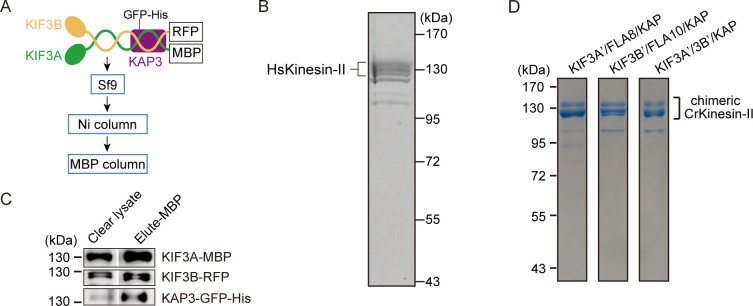
Purification of recombinant HsKinesin-II and chimeric CrKinesin-II with motor domains of HsKinesin-II.(A–C) Expression and purification of recombinant HsKinesin-II. Strategy of expression and purification (A). Purified kinesin-II was subjected to SDS-PAGE analysis followed by coomassie blue staining (B) or immunoblotting with antibodies against KIF3A, KIF3B or KAP3 (C). (D) Purification of chimeric CrKinesin-II with motor domains of HsKinesin-II. The motor domains of recombinant CrKinesin-II as shown in Figure 1A was replaced with one or two motor domains of HsKinesin-II as indicated. The resulting constructs KIF3A’-MBP/FLA8-RFP/KAP-GFP-His, KIF3B’-RFP/FLA10-MBP/KAP-GFP-His and KIF3A’-MBP/KIF3B’-RFP/KAP-GFP-His were expressed respectively in Sf9 cells followed by purification using MBP and Ni affinity columns consecutively. The purified products were analyzed by SDS-PAGE followed by commassie blue staining.